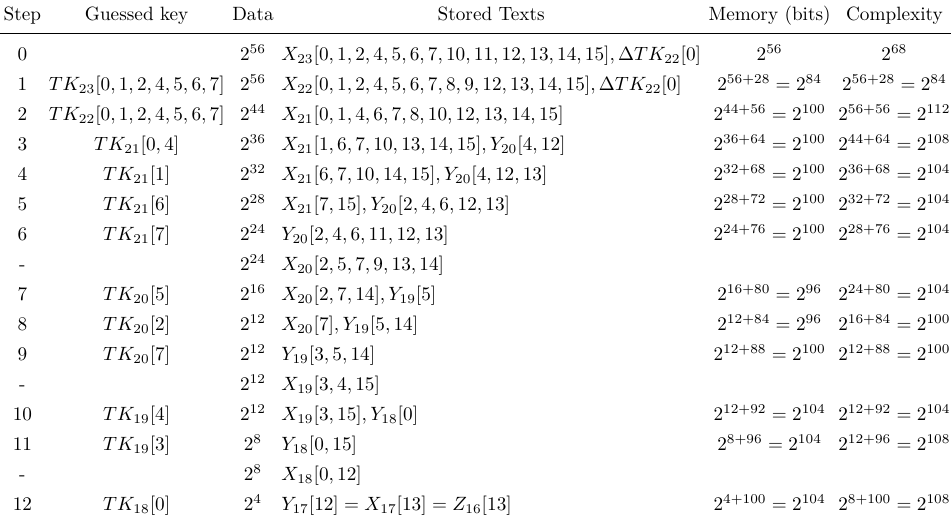
Table 5: Procedure for the key-recovery of L Z 16 [13] on Skinny